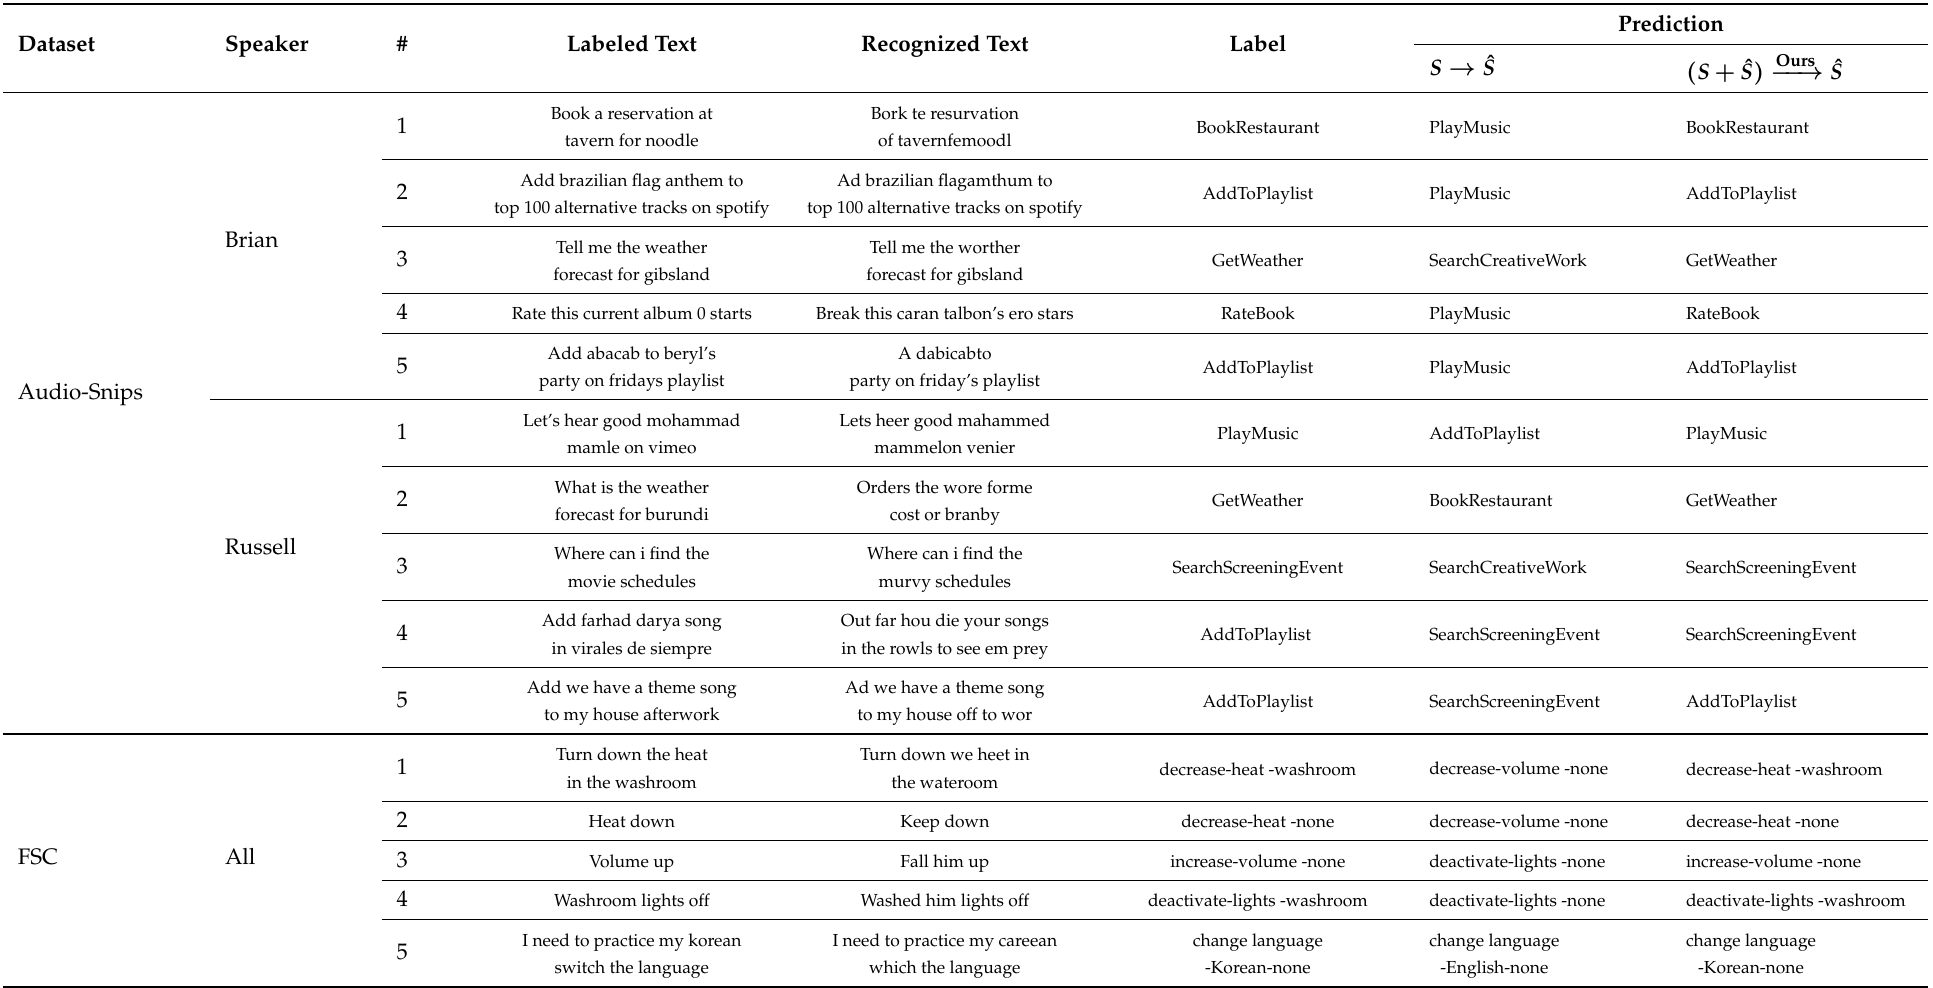
Table 6. Detailed results analysis of Brian, Russell, and the FSC